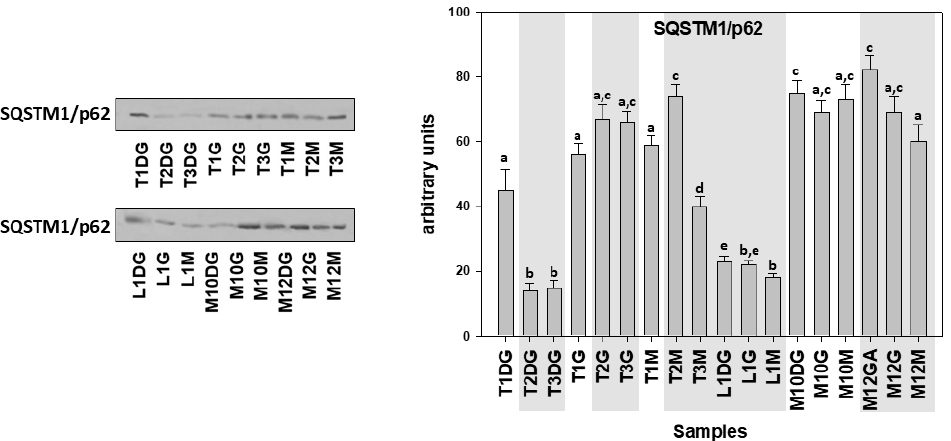
Figure 8. SQSTM1/p62 levels in the digestive gland (DG), gills (G), and mantle (M) of Pinna nobilis specimens from the Kalloni Gulf (Lesvos Island) (M10, M12), from the Thermaikos Gulf (Thessaloniki) (T01, T02, T03), and from Limnos Island (L1). All specimens were infected with mycobacterium and vibrio, while grey shaded areas represent specimens additionally infected with the haplosporidian parasite. Tissue extracts from all groups were immunoblotted for SQSTM1/p62. Blots were quantified using scanning densitometry. Representative blots are shown. Lower-case letters indicate statistically significant differences ( p < 0.05) between samples.